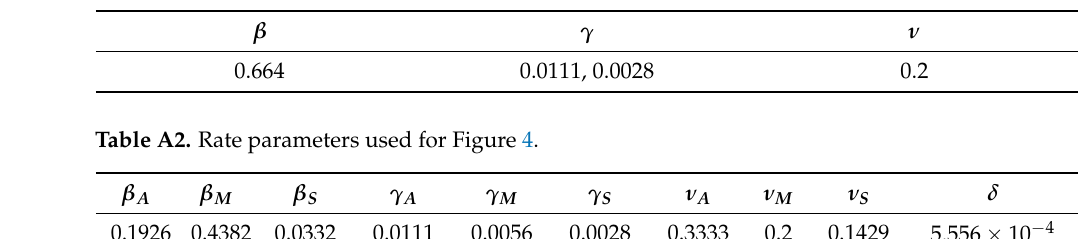
Table A1. Rate parameters used for Figure 2.